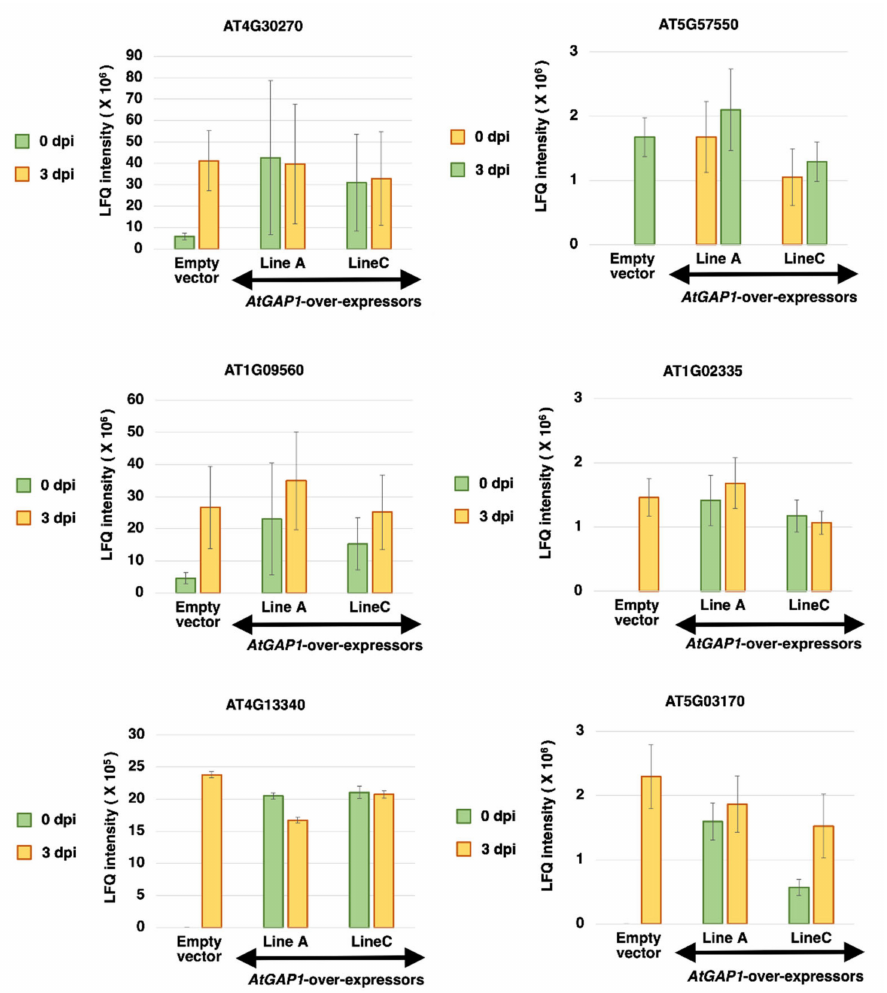
Figure 5. AtGAP1 overexpression primes the production of cell-wall-modifying proteins in Arabidop- sis before any exposure to the pathogen Pst DC3000. The label-free quantification (LFQ) intensities of cell-wall-modifying proteins extracted from the leaves of five-week-old Arabidopsis plants, in- cluding XTH24 (AT4G30270), GLP4 (AT1G09560), LRX3 (AT4G13340), GL22 (AT1G02335), XTH25 (AT5G57550), GL22 (AT1G02335), and FLA11 (AT5G03170), were compared among the empty vector control, AtGAP1- overexpressing line A, and AtGAP1 -overexpressing line C at 0 and 3 dpi (days post-inoculation) of Pst DC3000. The error bar represents the standard error of six technical replicates from three biological